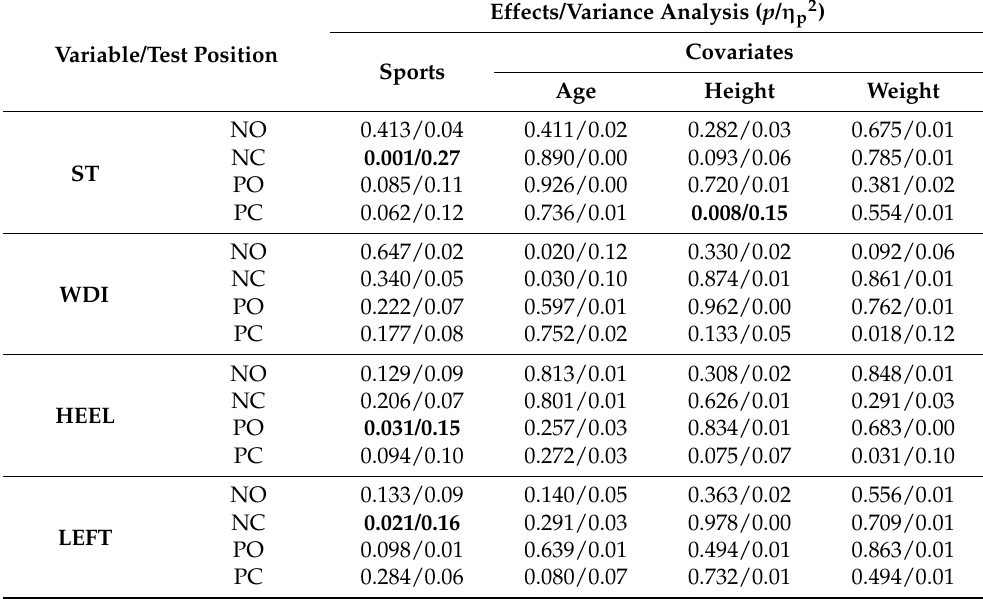
Table 3. Analysis of variance (covariates: age, mass, and height) between groups by test condition (eyes open, stable surface (NO, eyes closed, stable surface (NC, eyes open, unstable surface (PO, and eyes closed, unstable surface (PC) and postural control parameters. Significant differences ( η p2 ≥ 0.14) between sports indicated in